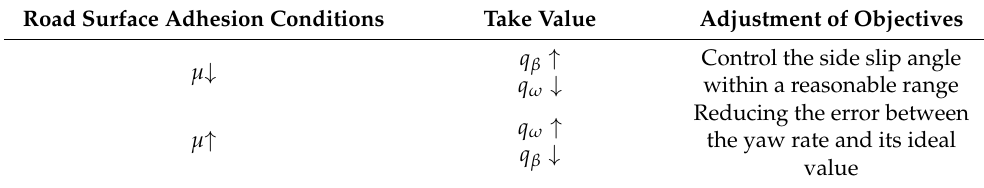
Table 5. Dynamic adjustment rules. Road Surface Adhesion